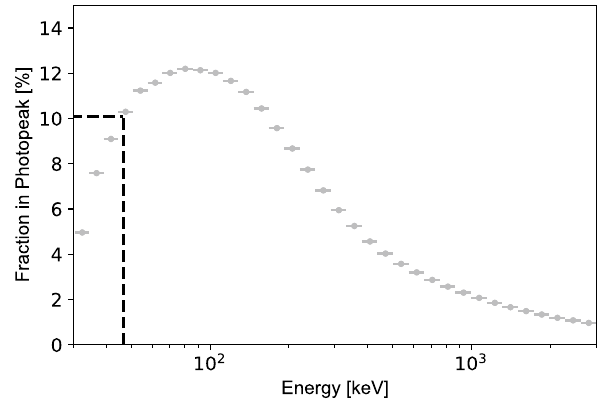
Fig. 6 Spectrum showing simulated efficiency of R osebeRRy detec- tor. For an energy of 46.5 keV it describes a geometric efficiency of 10.2%, highlighted in the black dotted